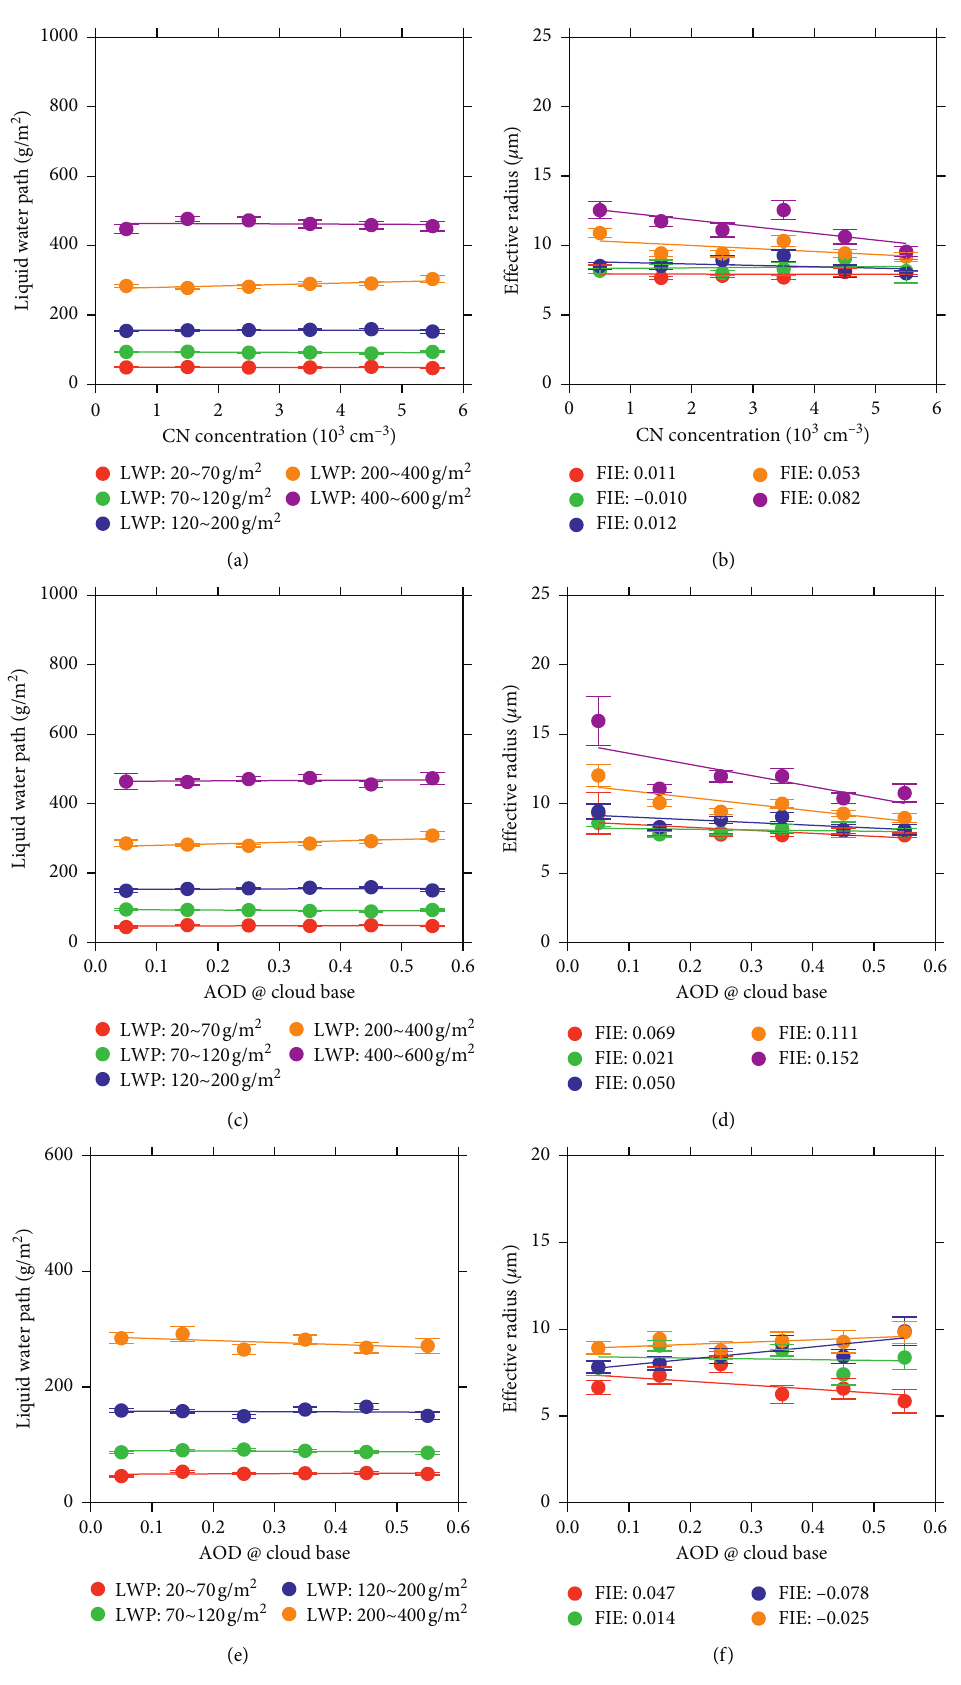
Figure 4: Cloud liquid water path at the (a) and (c) SGP and (e) SACOL sites and cloud effective radius at the (b) and (d) SGP and (f) SACOL sites as a function of aerosol loading for single-layer overcast clouds. Data are binned according to site-specific LWP bins. Values for the aerosol first indirect effect (FIE) are